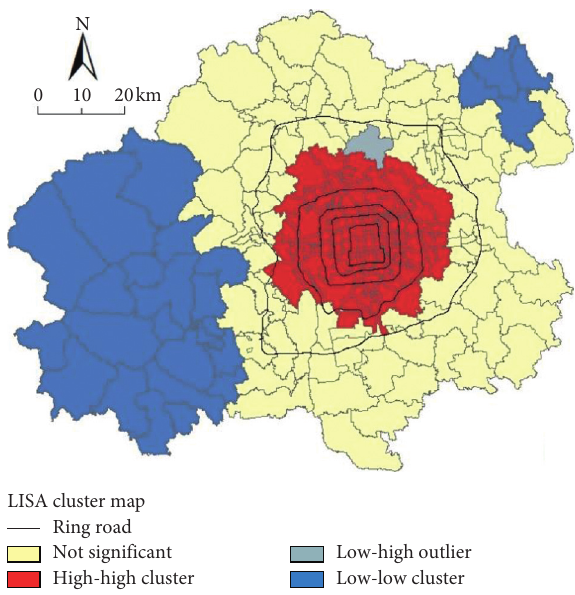
Figure 4: LISA cluster map of comprehensive